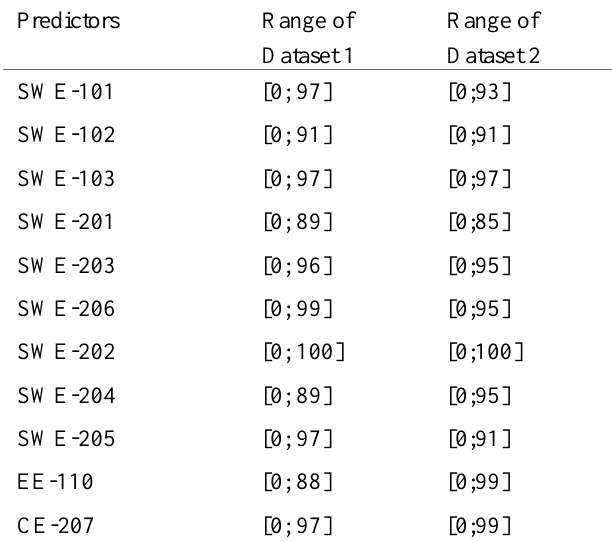
Comparison of datasets for Technical